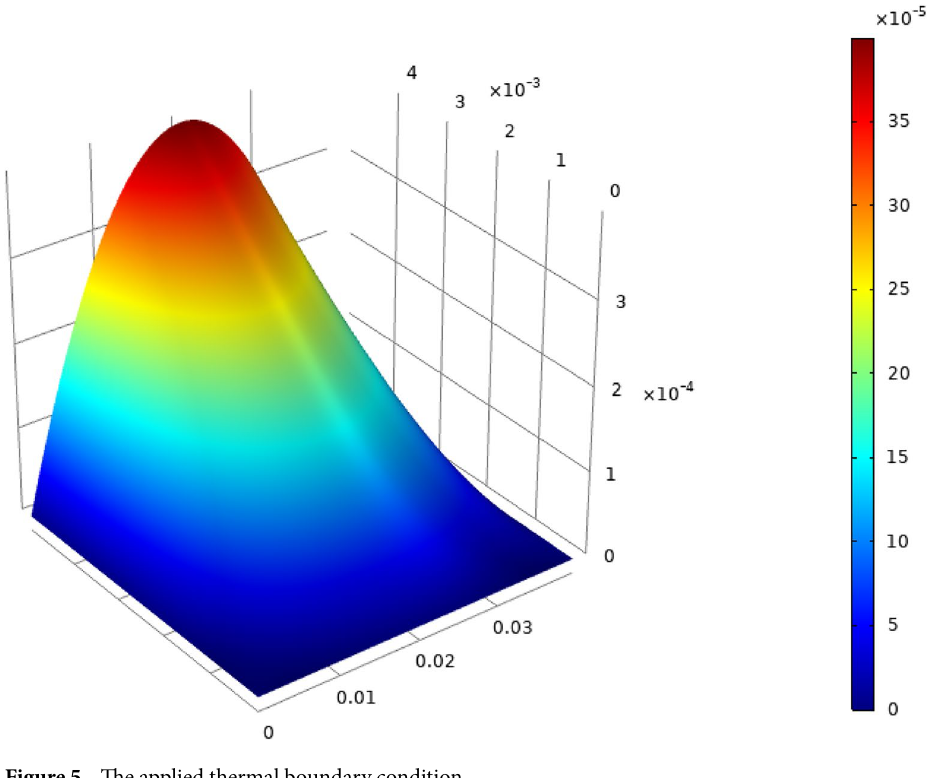
Figure 5. The applied thermal boundary condition.